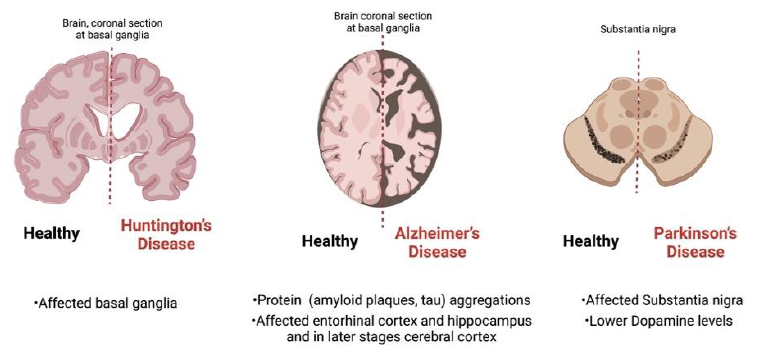
Figure 3. Main observations of a patient’s brain with neurodegenerative disorders. HD affects the basal ganglia, resulting in affective, cognitive, behavioral, and motor decline. AD affects the hippocampus, entorhinal cortex, and cerebral cortex, leading to brain shrinkage, memory loss, and general and thinking skills decline. PD, which affects the substantia nigra, and low dopamine levels cause bradykinesia, tremors, and motor impairment (created with BioRender.com).